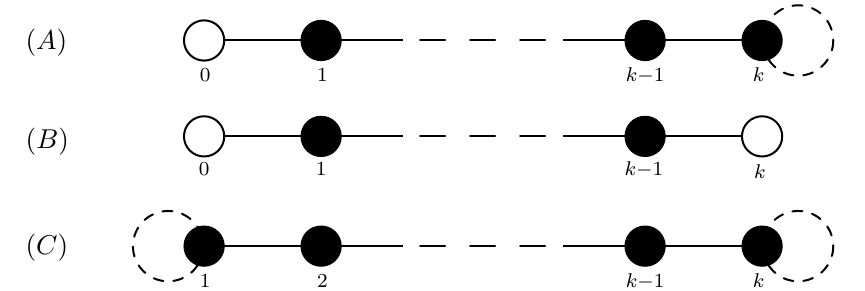
Figure 2 . The 5d quiver gauge theories of discussed in [65]. Black nodes represent SU(2 N ) gauge groups and white ones USp(2 N ) gauge groups. Solid lines denote bifundamental hypermultiplets and dashed lines hypermultiplets in the antisymmetric representation. In addition, at any given node, a , one may have N a number of fundamental hypermultiplets, which we have not f